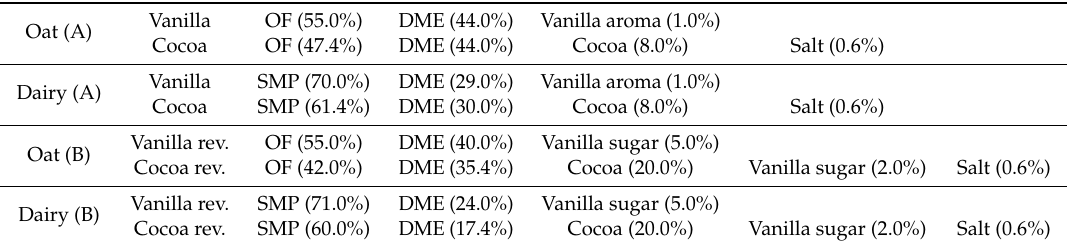
Table 2. Ingredient composition (%) of oat and dairy snack bases before (A) and after (B) revision. OF = Oat flour; SMP = Skim-milk powder; DME = dry malt extract. Berry flavor was not formulated as a separate base but was produced by adding berry powder to vanilla-based